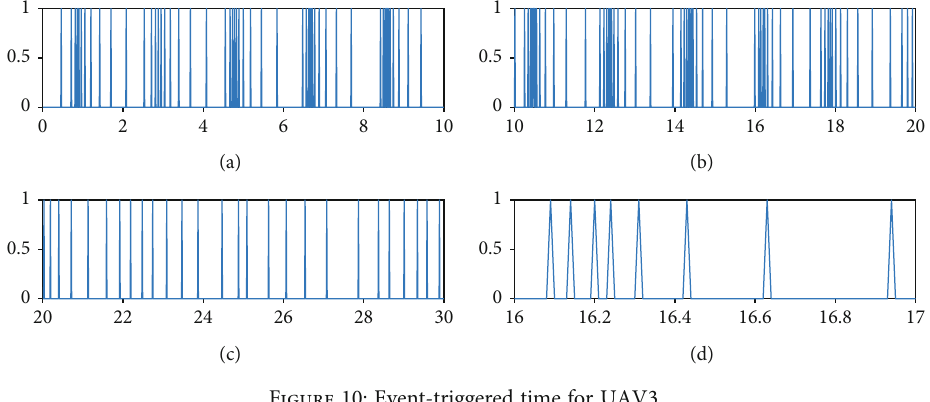
Figure 10: Event-triggered time for UAV3.